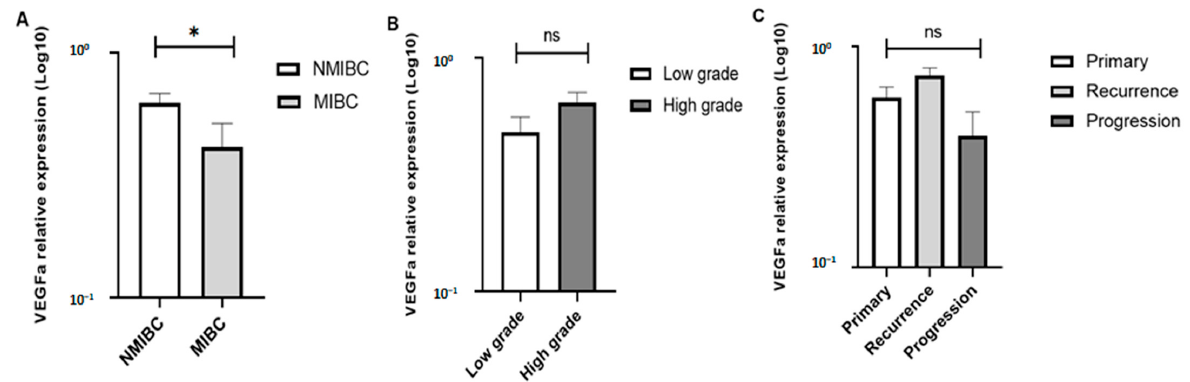
Figure 1. VEGFA expression levels according to tumor staging ( A ), grading ( B ), and follow-up ( C ). *: p values < 0.05; ns (not significant): p values ≥ 0.05. ( B ): Tumor grading was performed for NMIBC and MIBC cases; ( C ): Progression and/or recurrence rates were performed only for NMIBC cases.